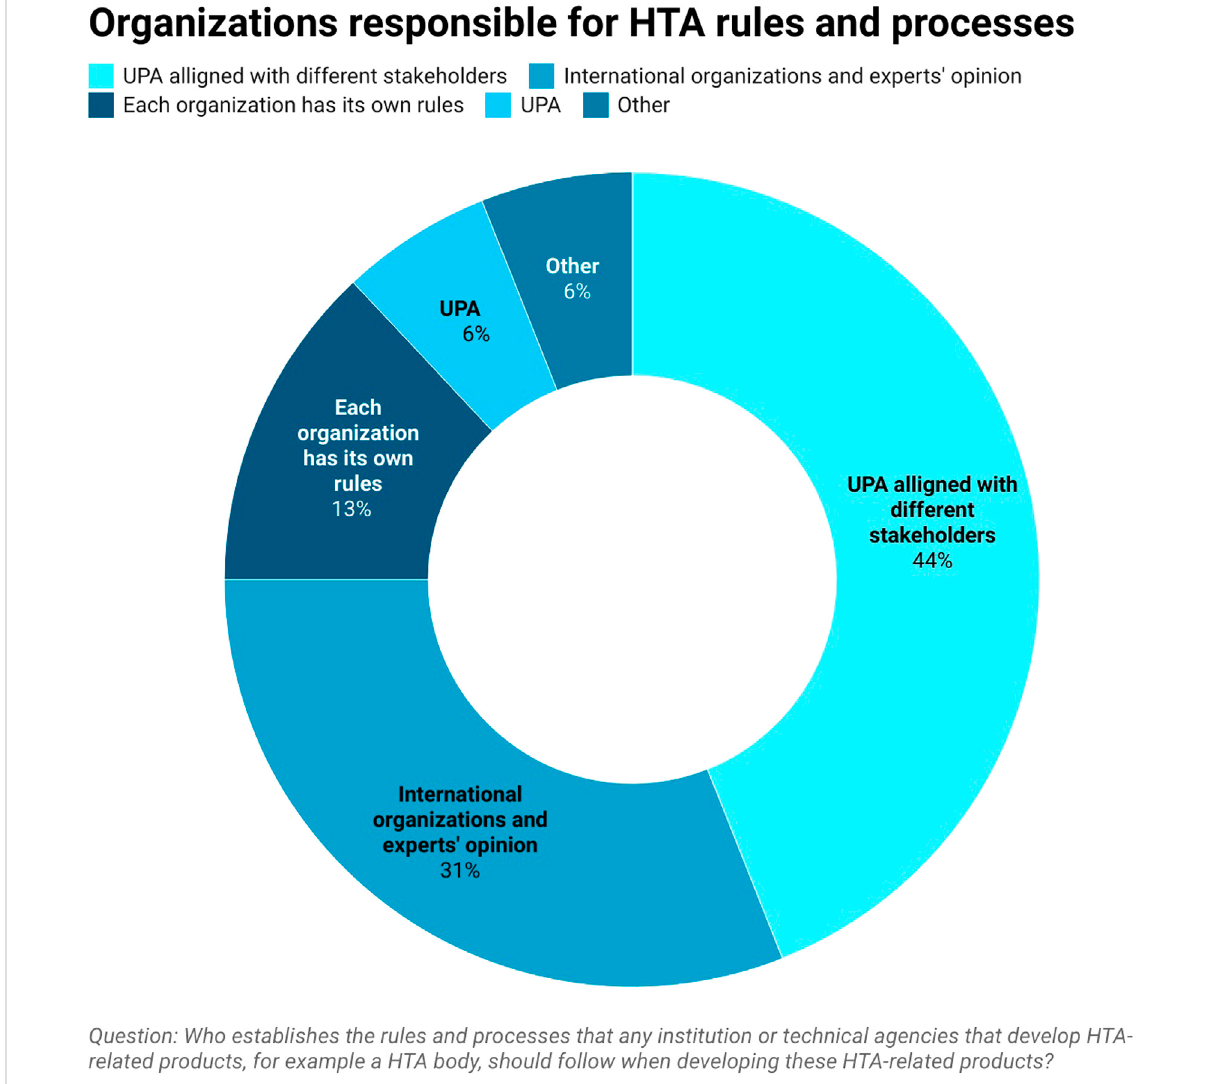
FIGURE 1 Organizations responsible for HTA rules and